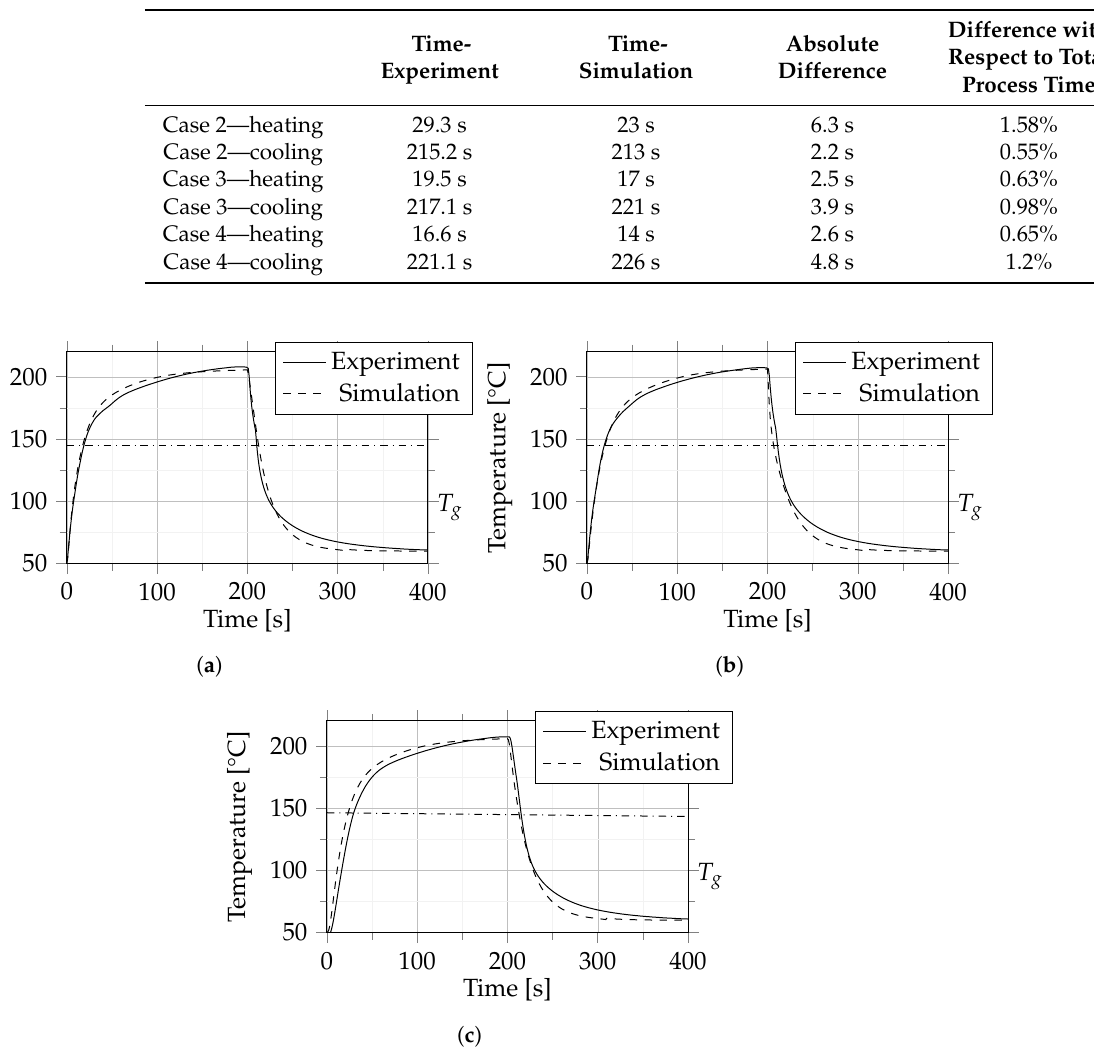
Table 4. Comparison between experiment and simulation regarding times when glass transition temperature is reached.